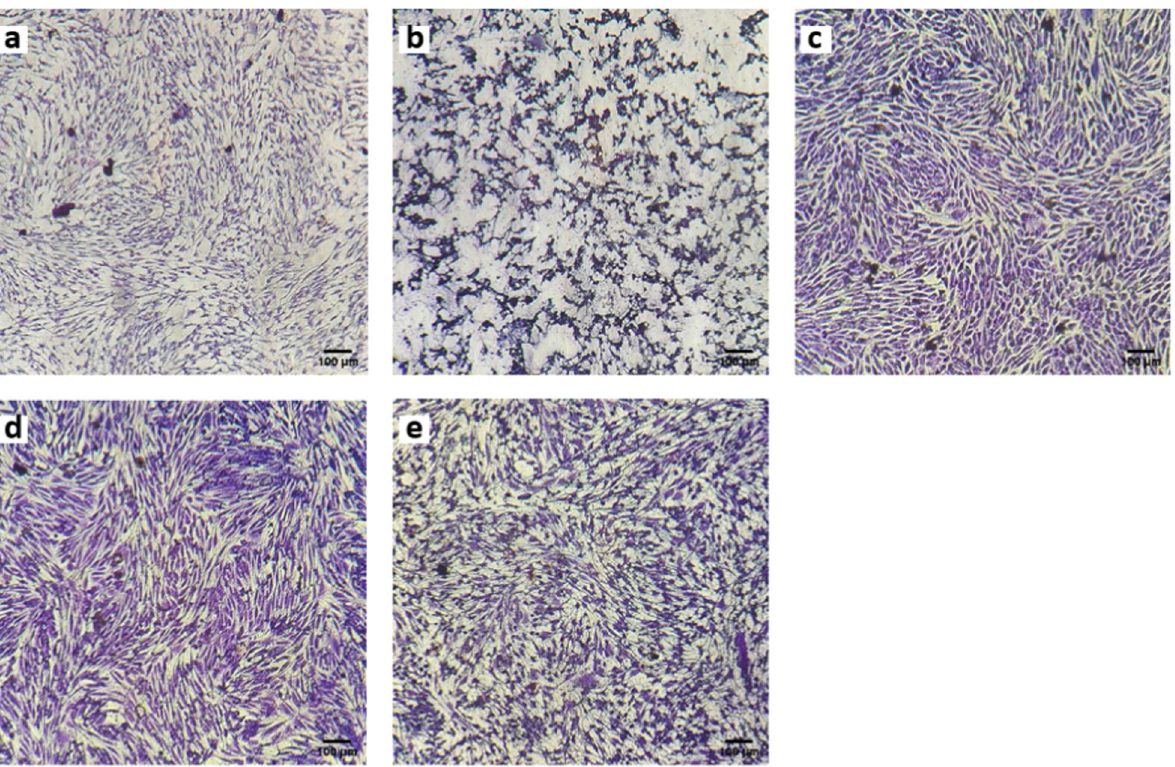
Fig. 8 Microscopic images of Crystal Violet-stained osteoblasts in contact with extracts of the fi lms for 24 h. a CWE, ( b ) PU, ( c ) PU-PEG 0.05, ( d ) PU-PEG 0.10, ( e ) PU-PEG